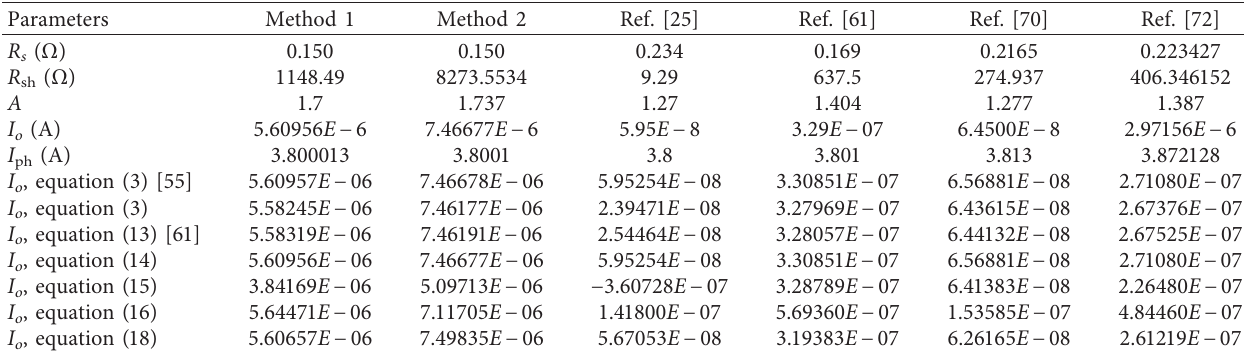
Table 10: Calculated parameters and data from simulations for Solarex